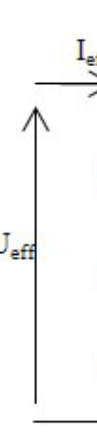
Figure 1. RLC series circuit